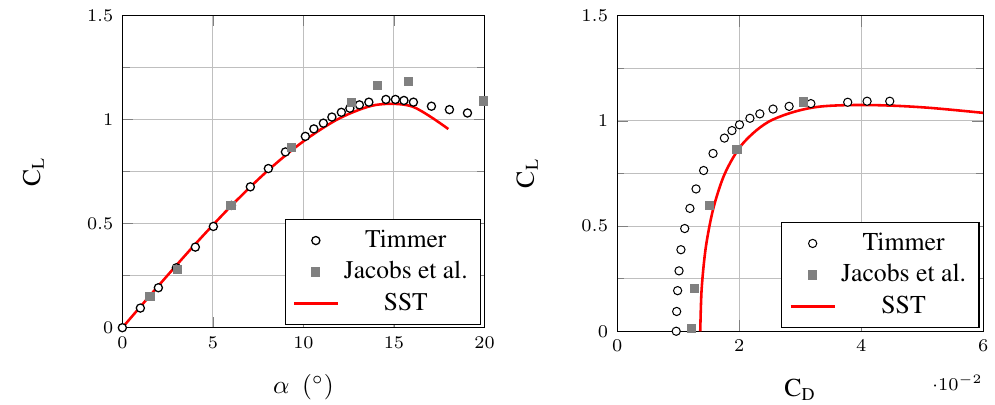
Figure 6. Lift coefficient as a function of angle of attack ( left ) and as a function of the drag coefficient ( right ). Comparison of simulations with experiments from Timmer [42] and from Jacobs et al.